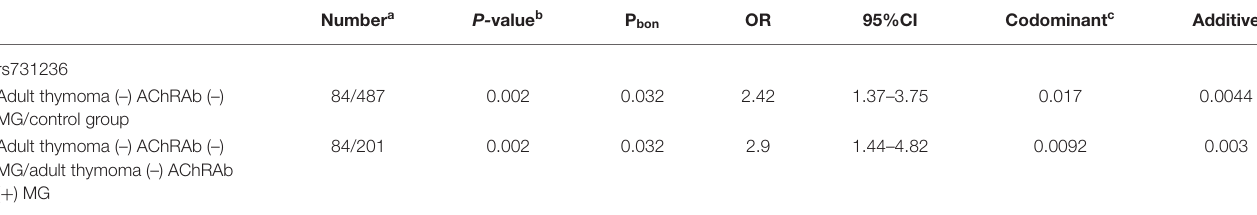
TABLE 2 | Significant differences in subgroups and healthy controls.